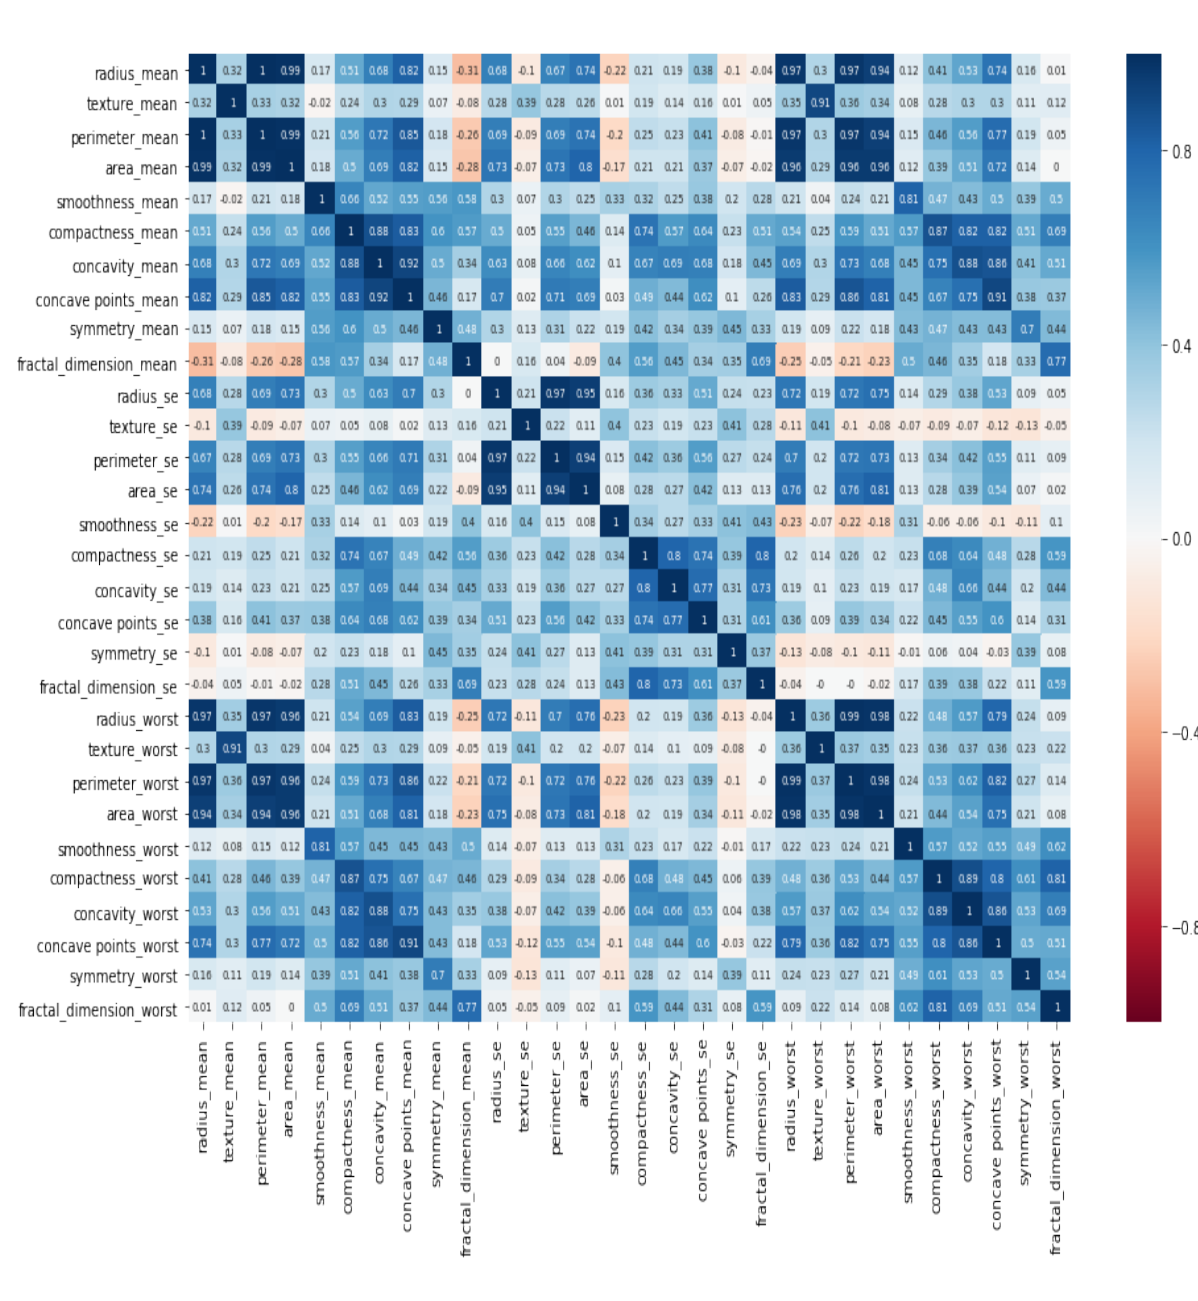
Figure 1. Correlation matrix heat